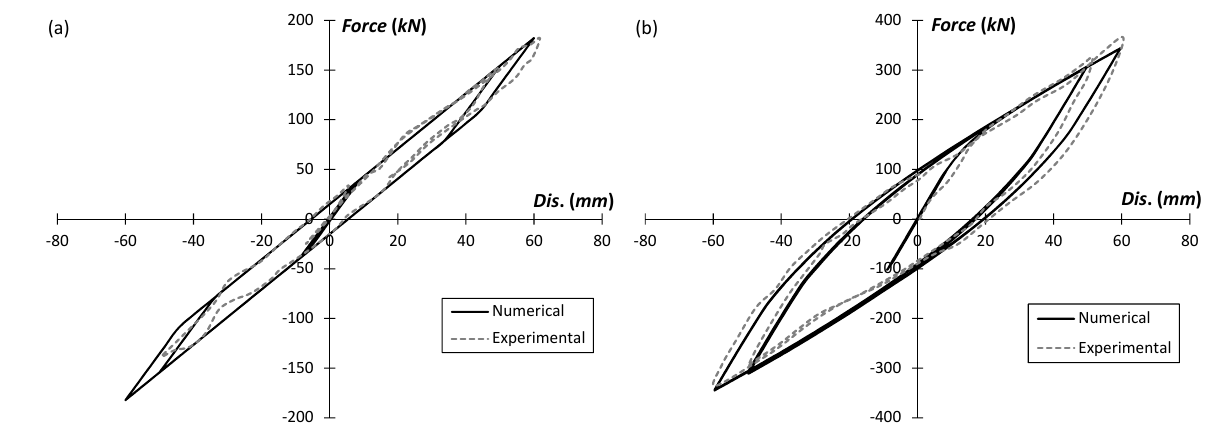
Figure 9. Hysteresis curves of experimental sample [57] and numerical model of ( a ) rubber isolator and ( b ) rubber isolator equipped with steel bar hysteretic damper. Table 1. Mechanical properties of SMA materials.